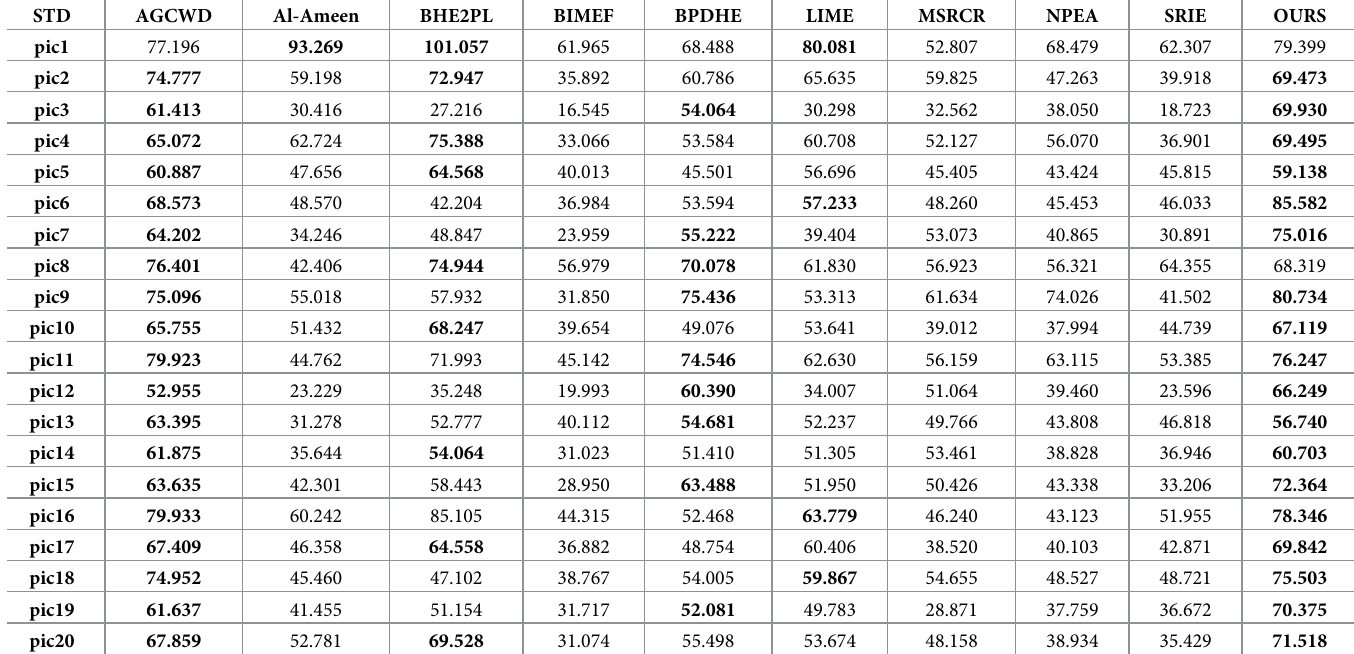
Table 15. Image standard deviation values of 20 random images of